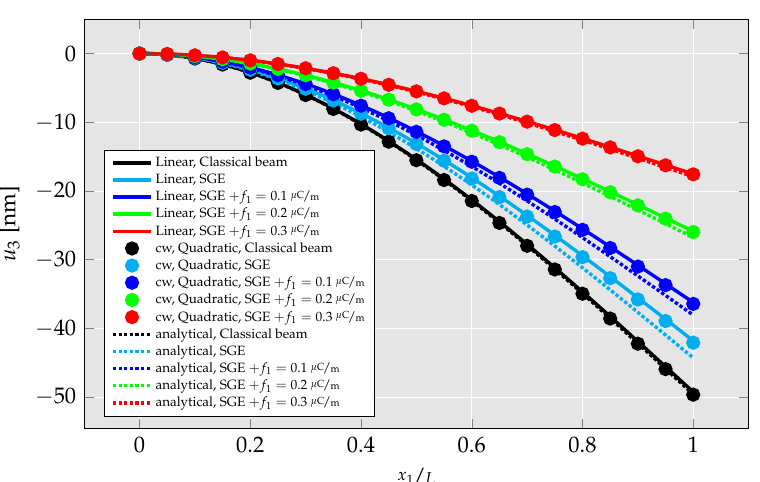
Figure 9. Deflection u 3 of the cantilever beam for linear and quadratic element with neglected strain gradient components, along with analytical solution. cw denotes the current